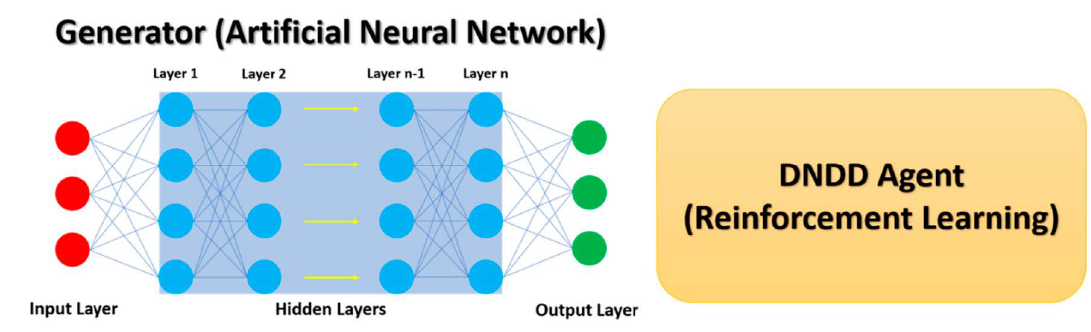
Figure 4. Deep reinforcement learning consists of a generator which is usually an artificial neural network and a de novo drug-design agent that uses reinforcement learning to make decisions for the generation of novel molecular